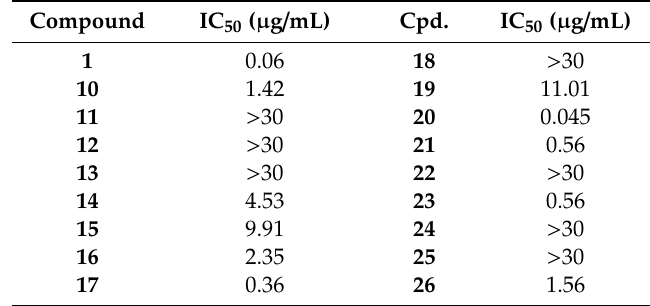
Table 2. In vitro anti-tubercular activity of compounds 10–26 against M.tb H37Ra on day 8 [24]. Compound IC 50 (µg/mL) Cpd. IC 50 (µg/mL)